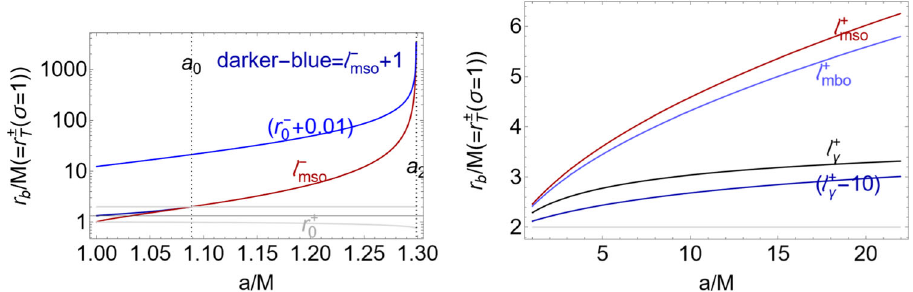
Fig. 26 Maximal extension on the equatorial plane of the inversion radius r ± (cid:2) = r b for fluids with specific angular momentum (cid:6) − (left panel) and (cid:6) + < 0 (right panel). Notation ( mso ) refers to marginally